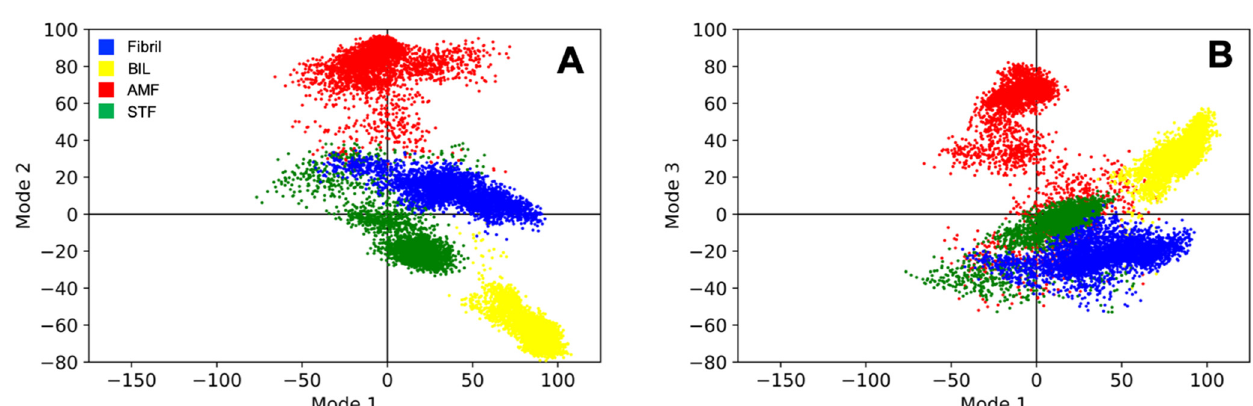
Figure 7. Principal component analysis (PCA) results from the ligand-free simulation and three representative ligand-bound simulations. Projection of the individual trajectories onto the first and second dominant modes of motion and ( A ) first and third dominant modes of motion ( B ) for three ligand-bound simulations and the ligand-free simulation showing the difference in motion between systems. Simulations were performed with A β 42 alone (Fibril) or in the presence of bilobetin (BIL), amentoflavone (AMF), and sotetsuflavone (STF). Projections for the second and third dominant modes of motion can be found in the Supporting Information along with the data for all six simulations.